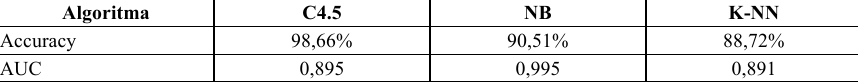
Table 9. Results of T-test